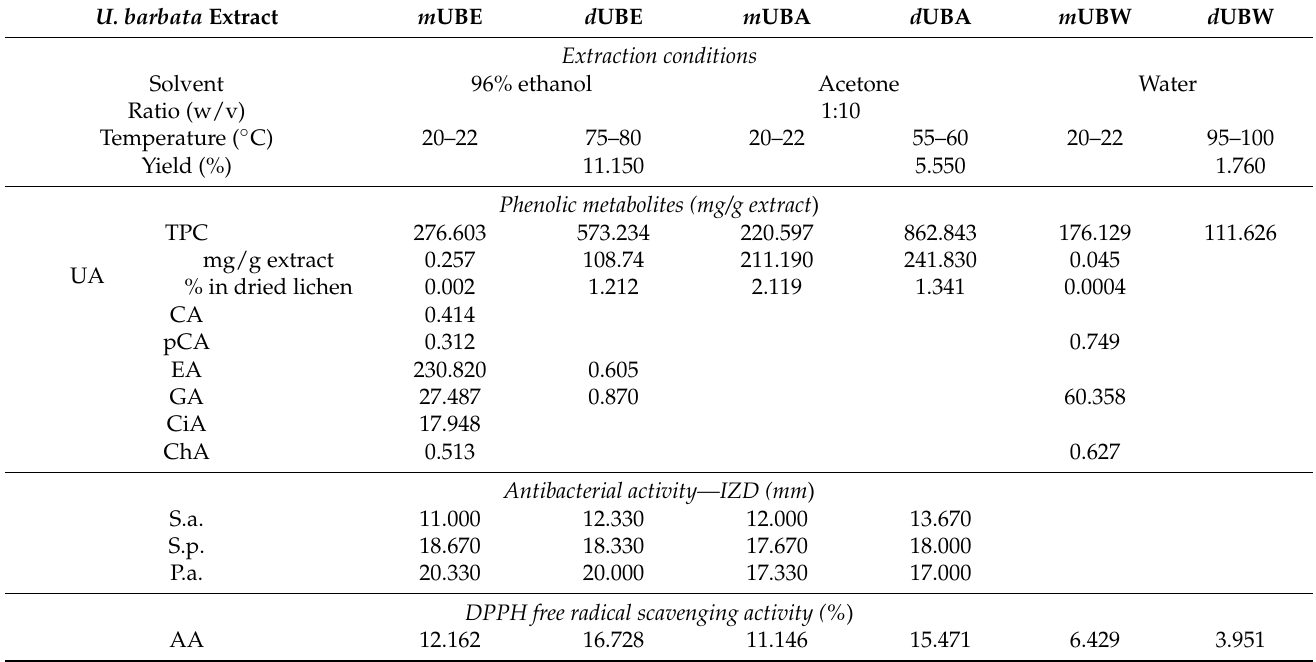
Table 7. Characteristics of U. barbata extracts in ethanol, acetone, and water obtained by two different conventional techniques, regarding the extraction conditions, phenolic metabolites, and